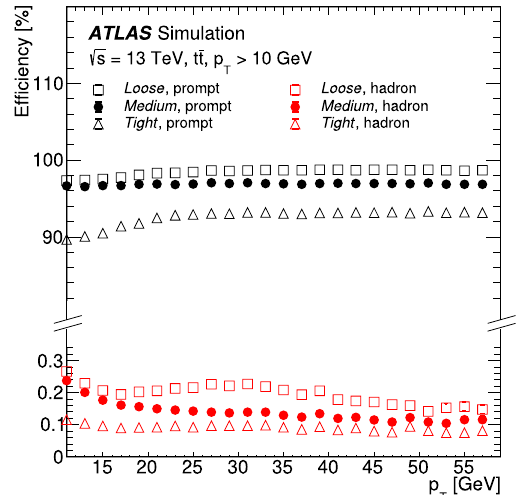
Fig. 1 Efficiency as a function of η (left) and p T (right) of the ID track for the Loose , Medium and Tight WP requirements in simulated t ¯ t events, shown separately for prompt muons and muons from light hadron decays. The efficiency is calculated as the fraction of ID tracks